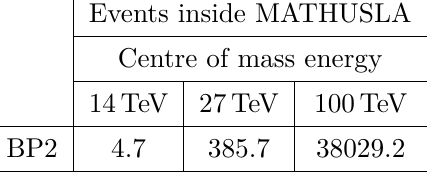
Table 7. The inclusive number of events inside the proposed detector, MATHUSLA, for the second benchmark point (BP2), at the centre of mass energies of 14, 27 and 100 TeV at an integrated luminosity of 3 ab − 1 , 10 ab − 1 and 30 ab − 1 , respectively.